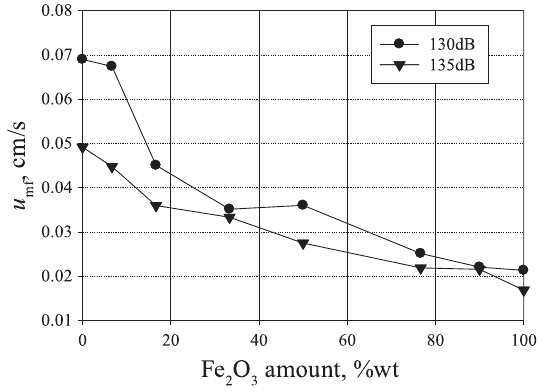
Fig. 6 Minimum fluidization velocity ( u mf ) of binary mixtures of Al 2 O 3 and Fe 2 O 3 as a function of %wt of Fe 2 O 3 in the mixture under different acoustic fields (120 Hz). Reprinted with permission from Ref. [Ammendola et al., 2011b]. Copyright: (2011) Elsevier